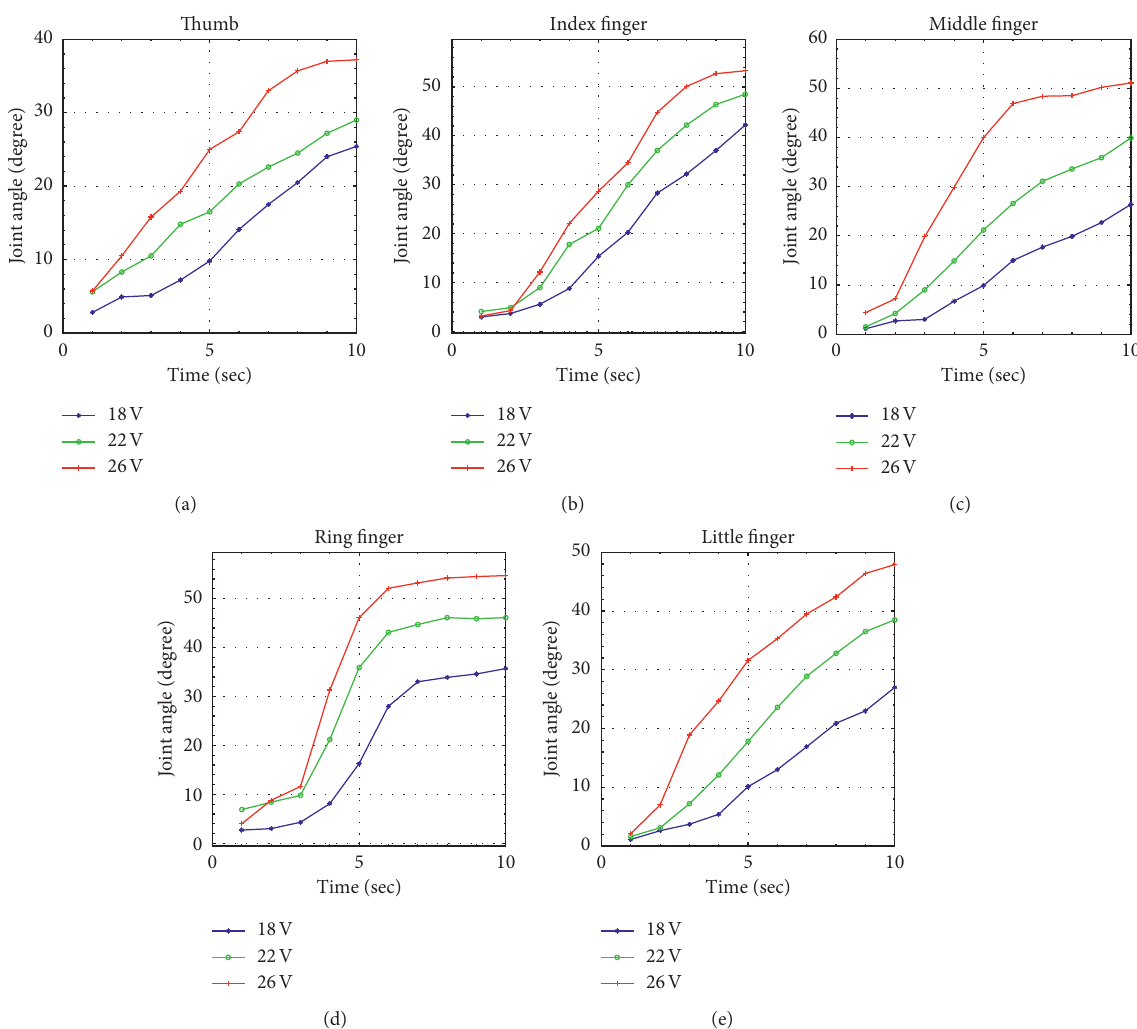
Figure 10: Relationship between joint angle and time of different